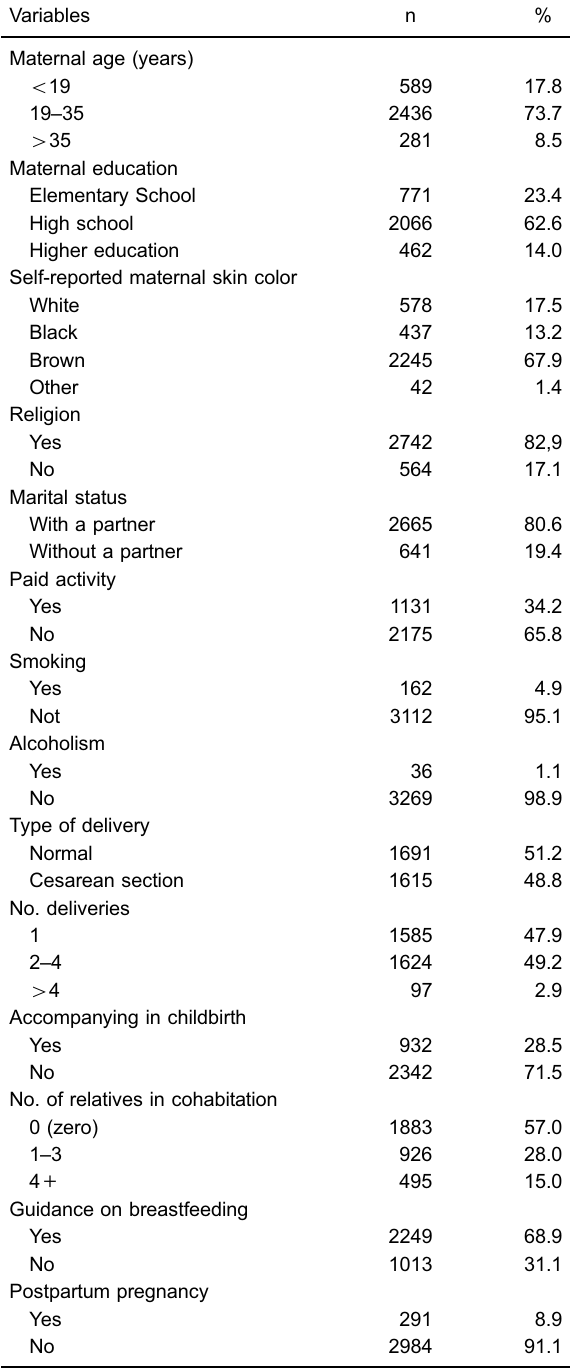
Table 1. Socioeconomic, demographic, and maternal life habits characteristics in São Luis, MA, Brazil, 2010 –